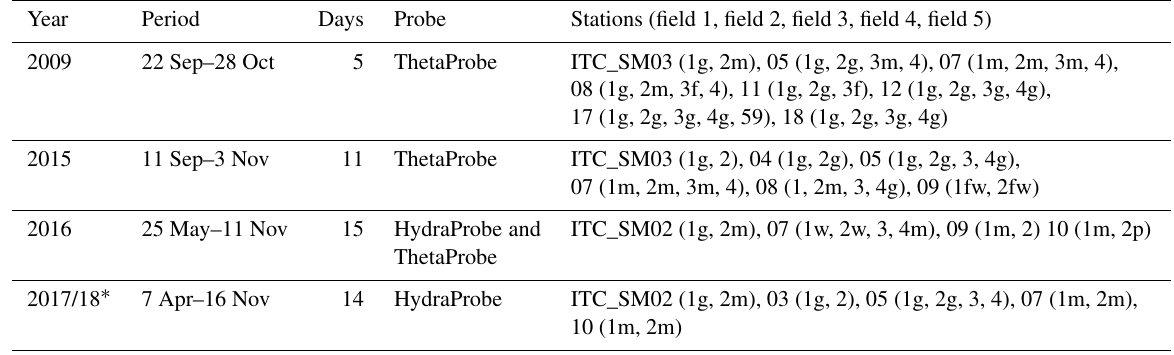
Table 2. Overview of the soil moisture field campaigns conducted at fields adjacent to monitoring stations. In the far right column, the number in parenthesis stands for the sampled field number, and the letter represents the land cover at the start of the campaign (g: grassland, m: maize, f: forest, fw: fallow winter wheat, w: winter wheat, p: potato). In case of no letter, the field was not sampled during the field campaign.